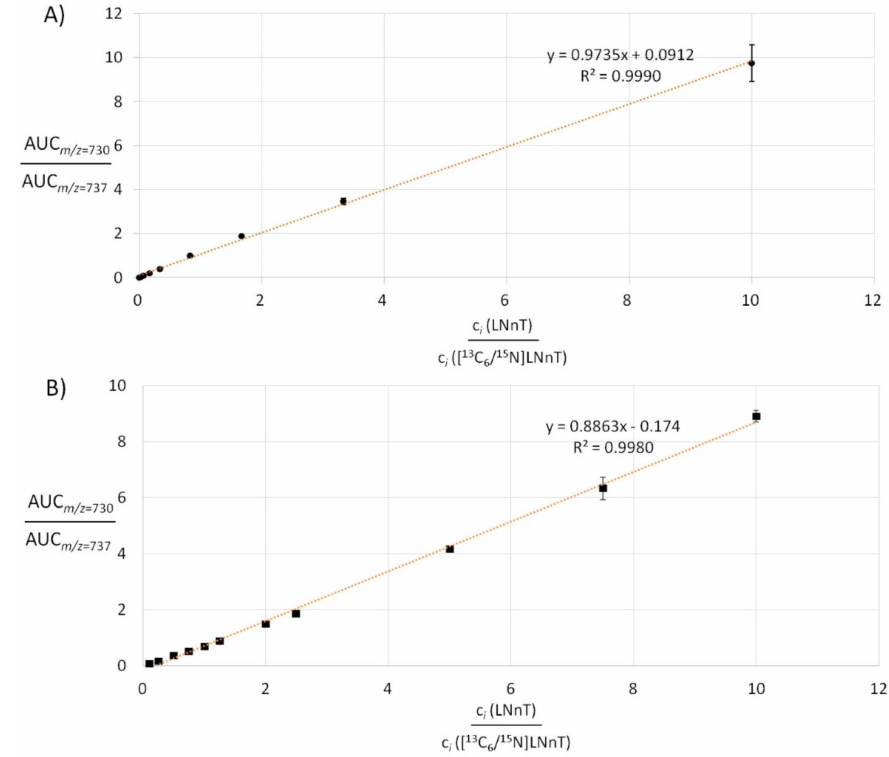
Figure 2. Calibration plots for the response function of LNnT to [ 13 C 6 / 15 N]LNnT by matrix-assisted laser desorption / ionization-time of flight mass spectrometry (MALDI-TOF-MS). [ 13 C 6 / 15 N]LNnT was mixed commercial LNnT in H 2 O ( A ) and bovine H-milk ( B ), covering a broad spectrum of concentrations (0.25 µ M to 1.5 mM). The graph displays averaged replicates with error bars representing the standard deviation ( n > 3). LNnT and [ 13 C 6 / 15 N]LNnT were purified from bovine H-milk (Weinstephan, 3.5% fat) by porous graphitized carbon-solid-phase extraction